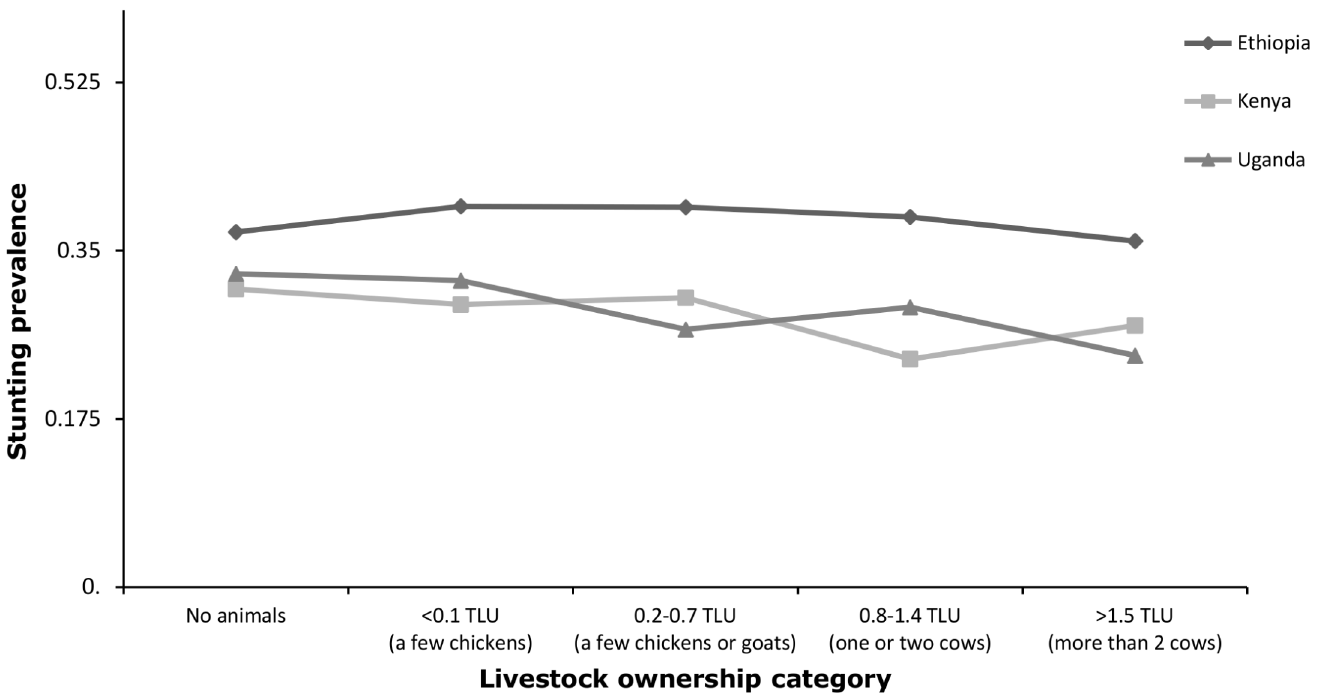
Fig 1. Unadjusted stunting prevalence by livestock ownership category in Ethiopia, Kenya, and